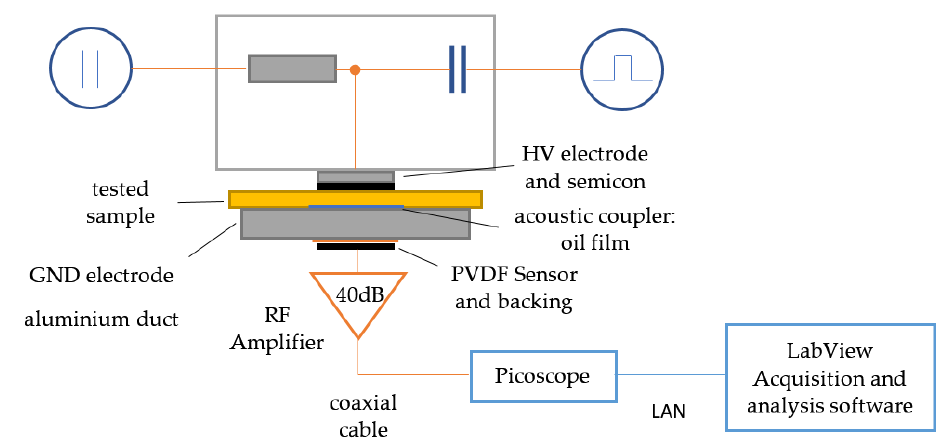
Figure 2. Scheme of used measurement setup for pea method.